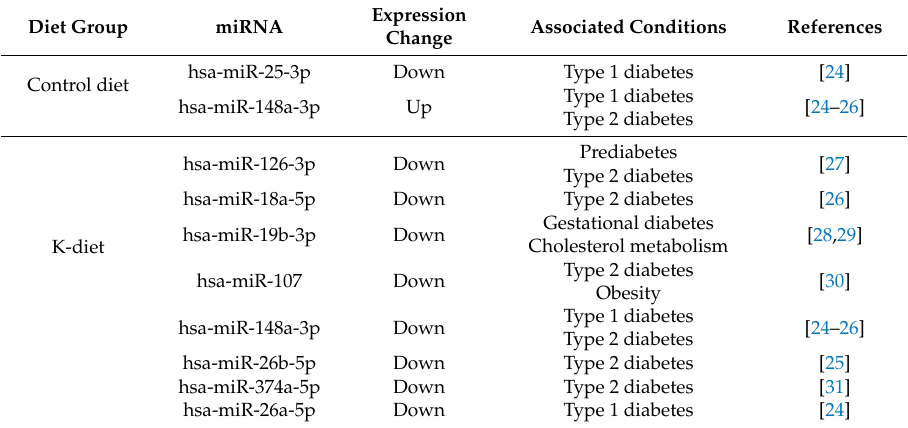
Table 5. Plasma microRNAs (miRs) changed in the screening array.